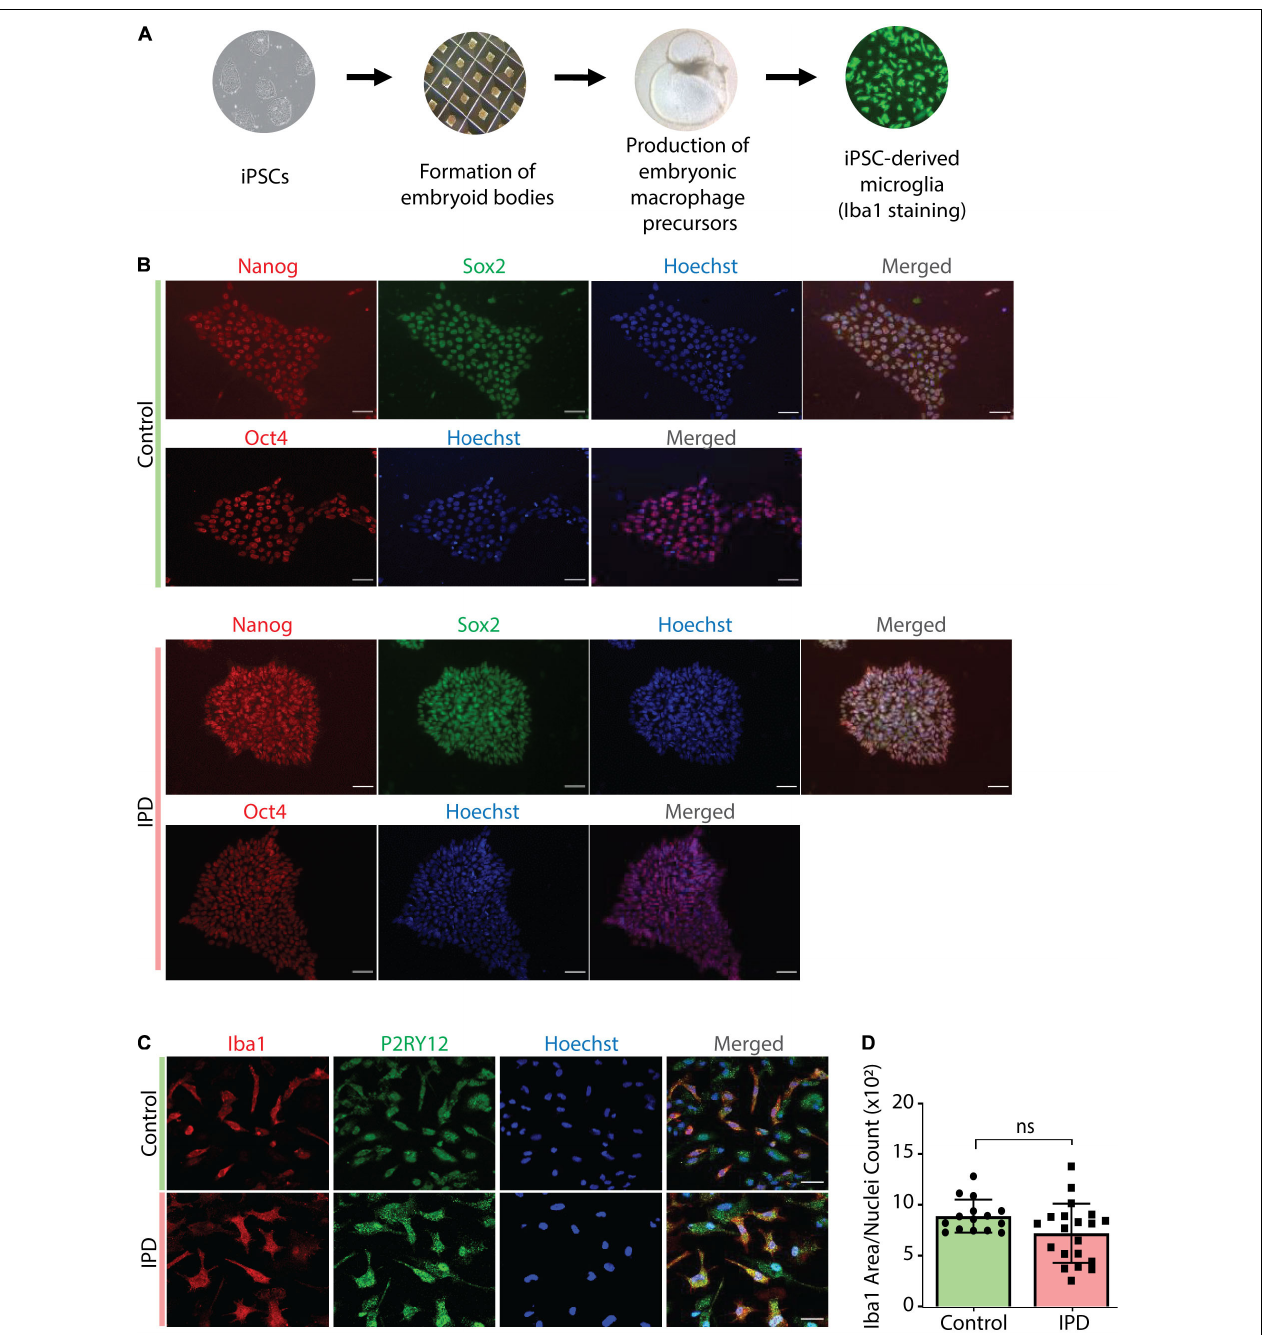
FIGURE 2 | Characterization of cellular models used in the study. (A) Overview of the protocol used to derive microglia from iPSCs. (B) Immunostaining with Nanog, Sox-2 and Oct-4, coupled with nuclear staining with Hoechst, confirmed the iPSC identity of our cells. Scale bar, 50 µ m. (C) Terminally differentiated microglia were confirmed to express the microglia-specific markers Iba1 and P2RY12. Scale bar, 30 µ m. (D) Quantification of data from (C) ; no difference in Iba1 protein levels (Iba1 area was normalized for nuclei count); IPD, idiopathic PD; CTR, healthy control.